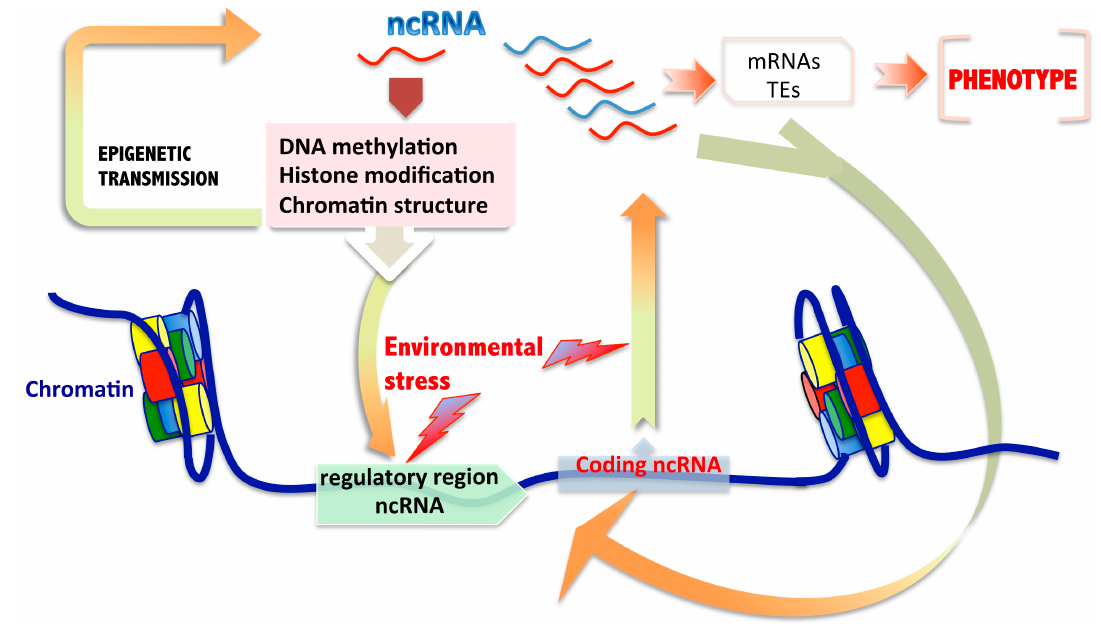
Figure 1. Schematic model of proposed mechanisms of epigenetic transmission of changes induced in ncRNAs by effects of environmental reprotoxicants. ncRNAs could contribute to inherit changes to successive generations through germ cells. This suggested model could involve different putative actors well-known as participants in epigenetic changes environmentally-mediated, including the effects of reprotoxicants.